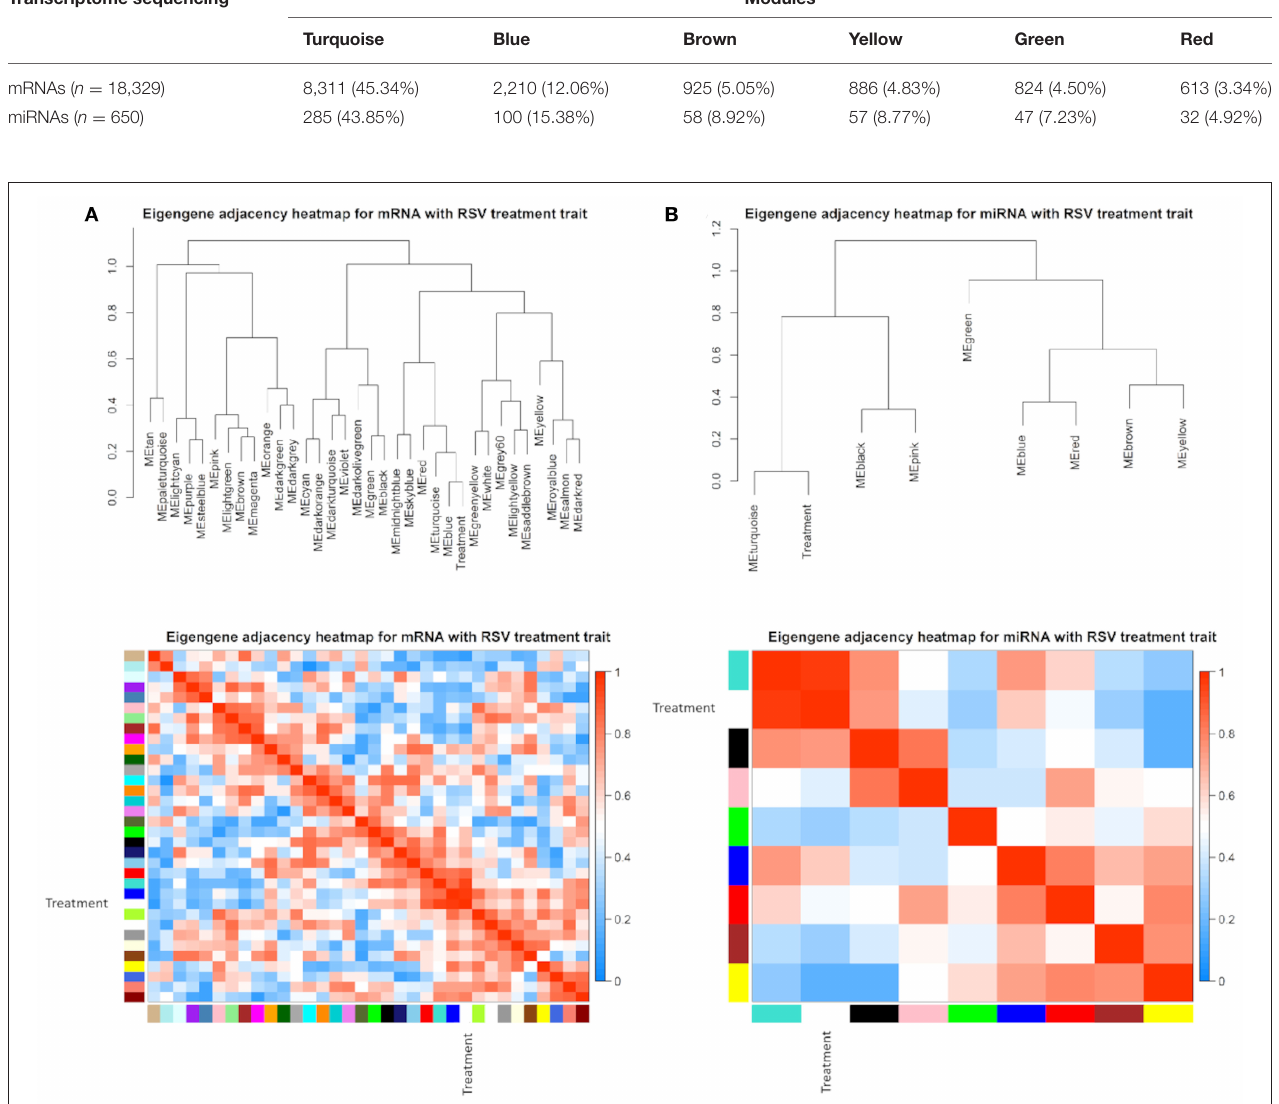
FIGURE 4 | Eigengene dendrogram and adjacency heatmap of different co-expression modules for (A) mRNAs and (B) miRNAs,